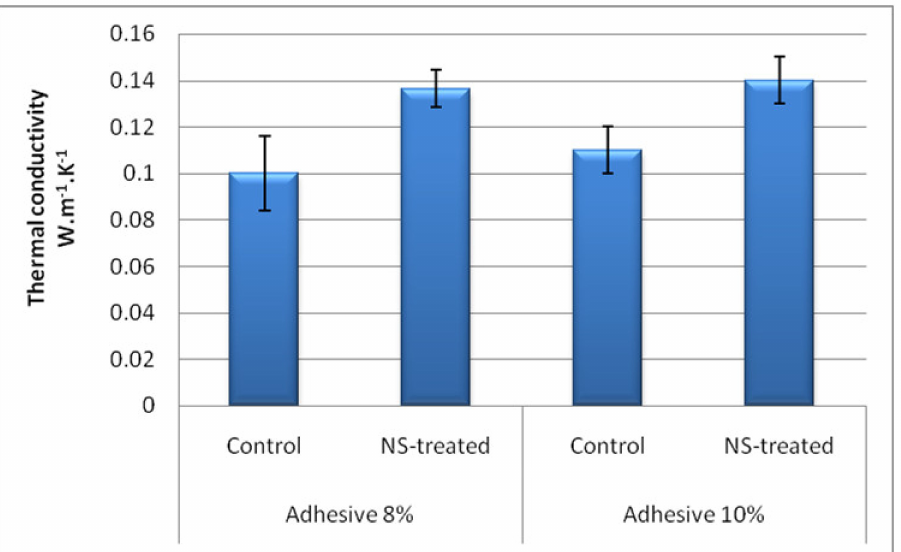
Figure 6. Mean thermal conductivity coe ffi cients (W · m − 1 · K − 1 ) for the four treatments (NS = nano-sepiolite).